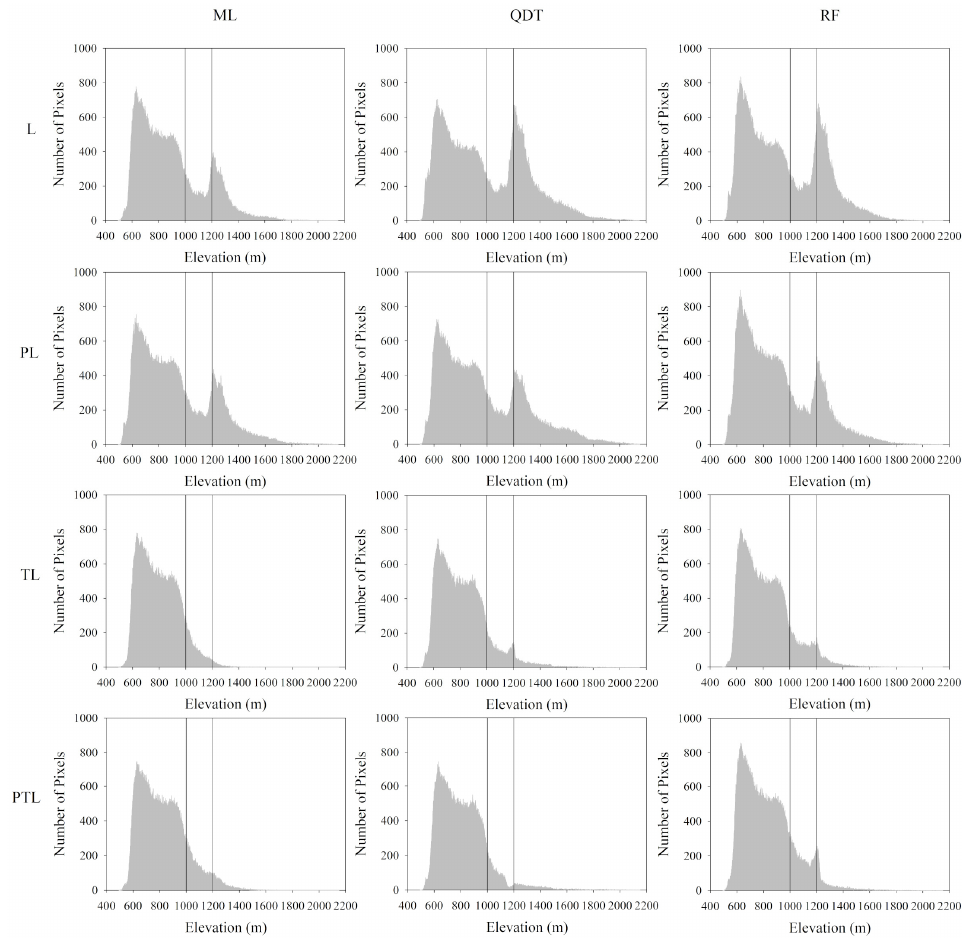
Figure A2. The elevation distribution of the classified rubber plantations based on three classifiers.